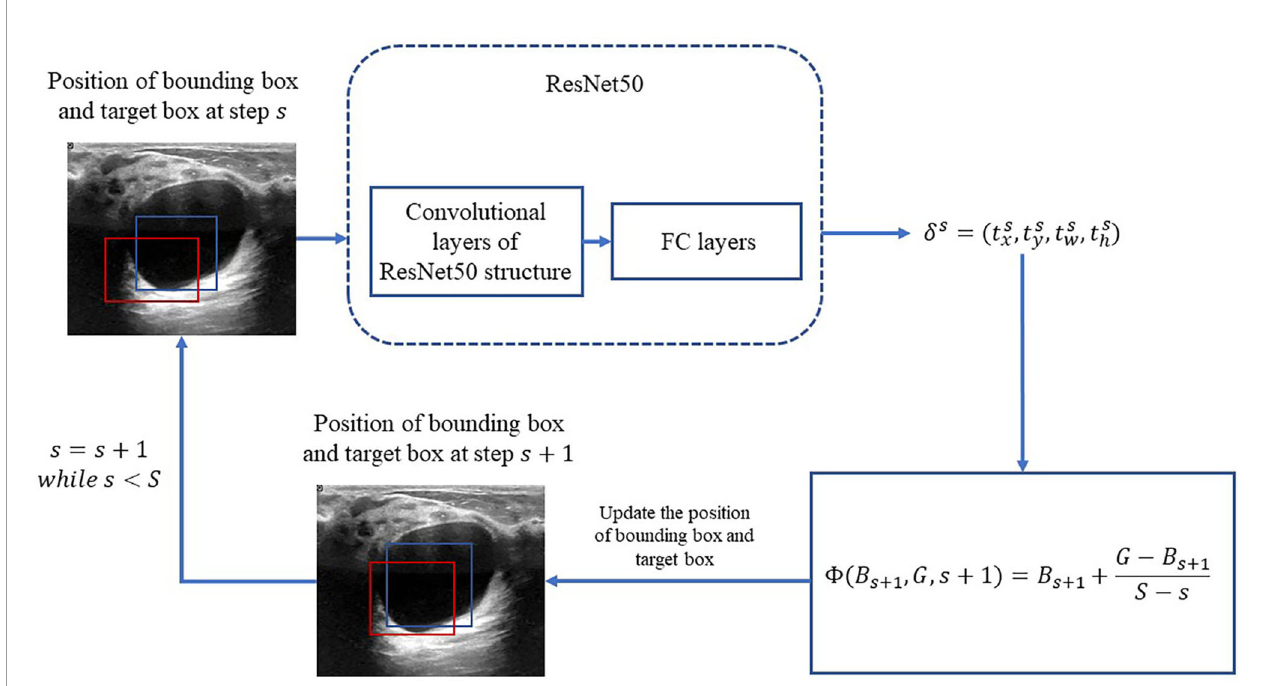
FIGURE 3 | Process of iterative bounding-box regression. The red rectangle represents the bounding box, and the blue one represents the target box. At each step, the network modi fi es the bounding box, and the target box coordinates and uses the new bounding box as the